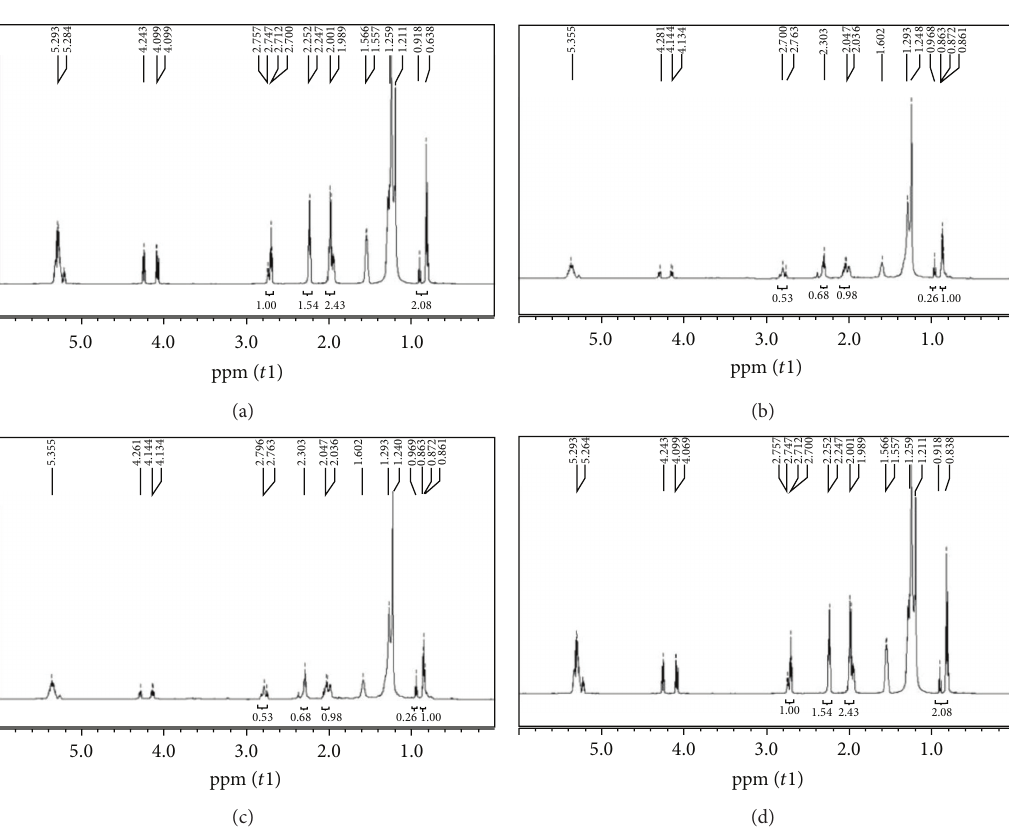
Figure 2: NMR determination for fatty acids profiles of extracts obtained by four different extraction techniques from H. pluvialis . ((a) NMR analysis of extract by HCI-ACE method; (b) NMR analysis of extract by HEX-IPA method; (c) NMR analysis of extract by MET-ACE method; (d) NMR analysis of extract by oil-soy method.)